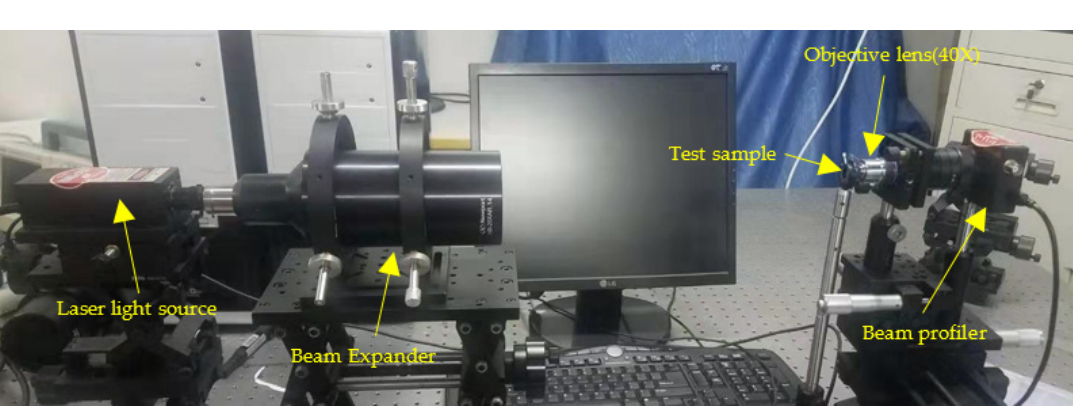
Table 2. Roughness related parameter table. Figure 8. Quantitative analysis of surface roughness of area-A. Figure 8. Quantitative analysis of surface roughness of area-A.